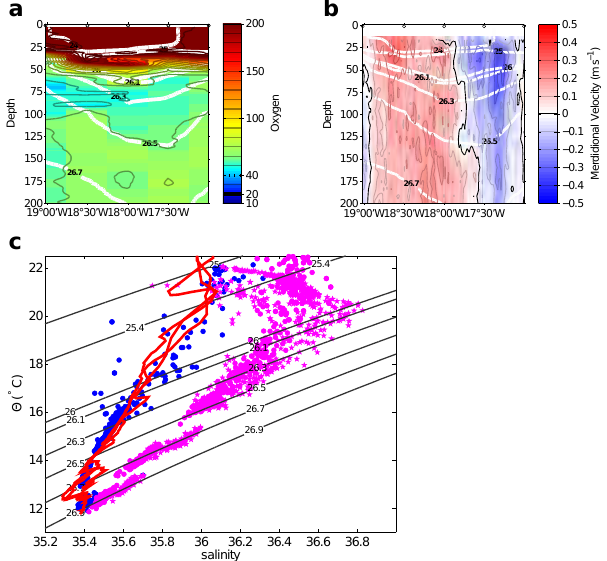
Figure 6. Vertical distribution of (a) oxygen (µmolkg − 1 ) and (b) meridional velocity (ms − 1 ) surveyed with RV METEOR (cruise M68/3) on the 18 July 2006, at 18 ◦ N and from 17 to 19 ◦ W (see Fig. 1 for position). (c) Hydrographic characteristics of the eddy core as observed with RV METEOR (red lines) and as observed 7 months later during the CVOO2007 passage (blue dots). For refer- ence typical background conditions at CVOO are shown (magenta dots and